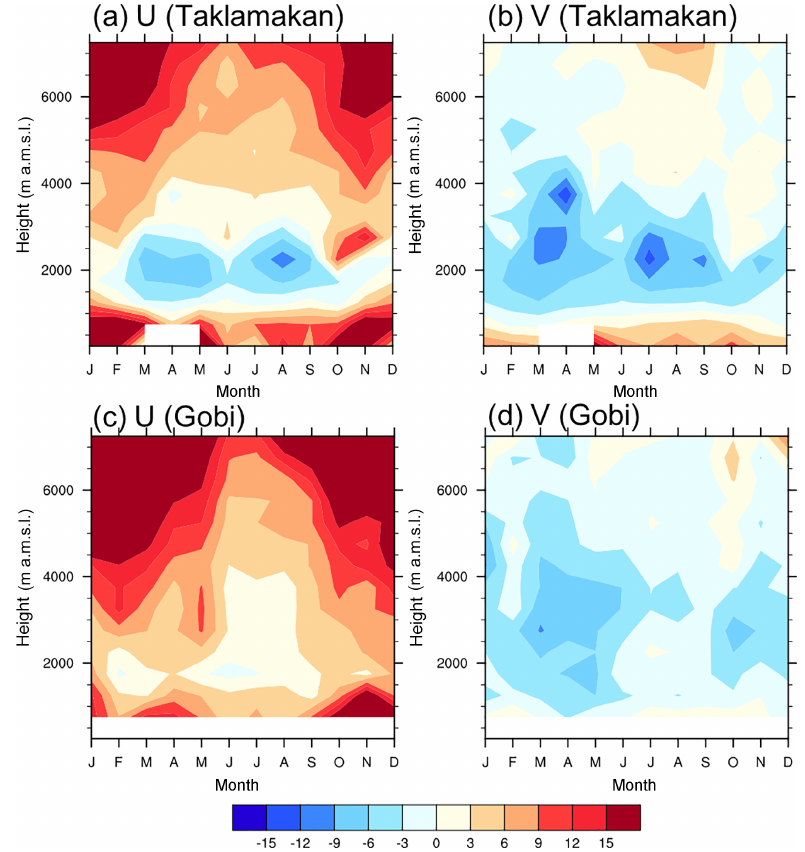
Figure 5. Regional average (a, c) zonal ( U ) and (b, d) meridional ( V ) wind (ms − 1 ) climatology across the (a–b) Taklamakan and (c–d) Gobi deserts, by month and height. The wind data are from MISR CMVP during 2001–2017, sampling the days with optically thick dust plumes or clouds. The missing cells represent levels below ground or sampled by CMVP for less than 10